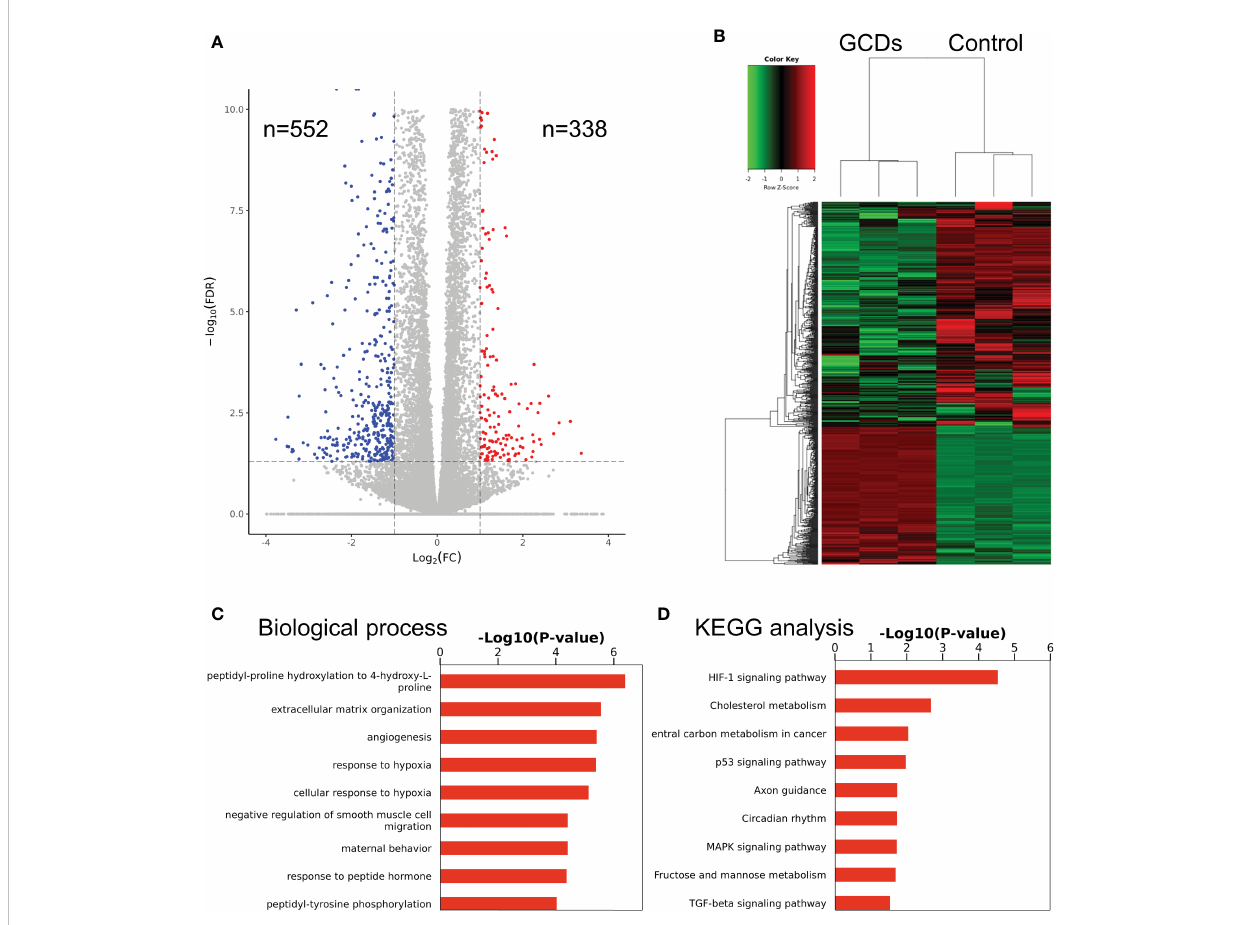
FIGURE 3 RNA sequencing of cells treated with ginseng-based carbon dots (GCDs). (A) Volcano map for the changes in gene expression in Cal-27 cells treated with GCDs. (B) Heatmap for the changes in gene expression in Cal-27 cells treated with GCDs. (C, D) GO and KEGG analysis for all genes with altered expressions in Cal-27 cells treated with